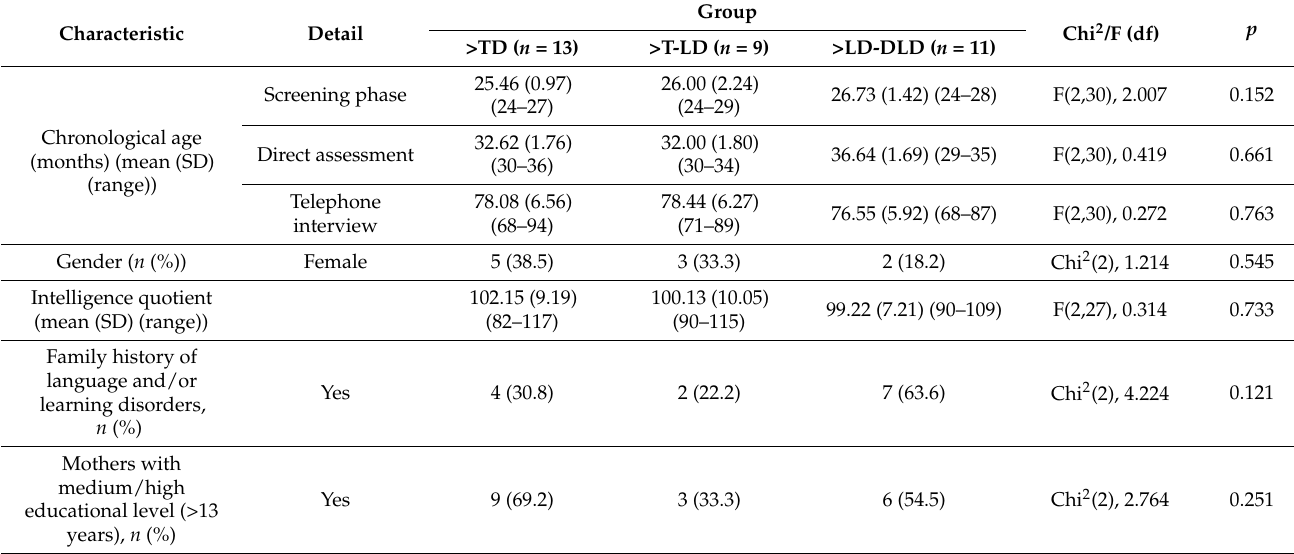
Table 1. Characteristics of the children included in the